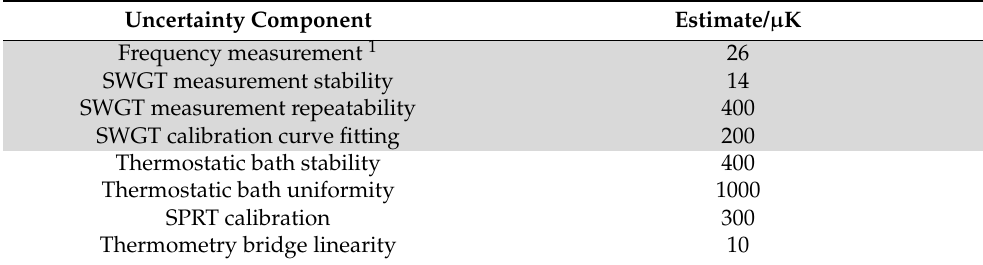
Table 2. Individual uncertainty components of the SWGT calibration. The estimates under a gray area refer to the temperature uncertainty contributions directly attributed to SWGT sensing capability.